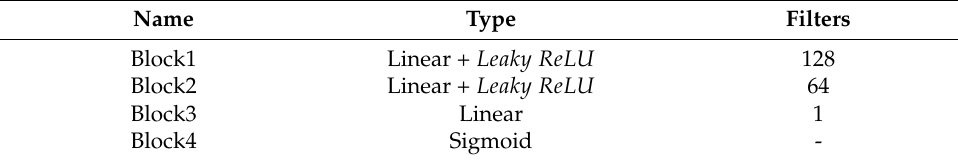
Table 3. Details of the discriminator